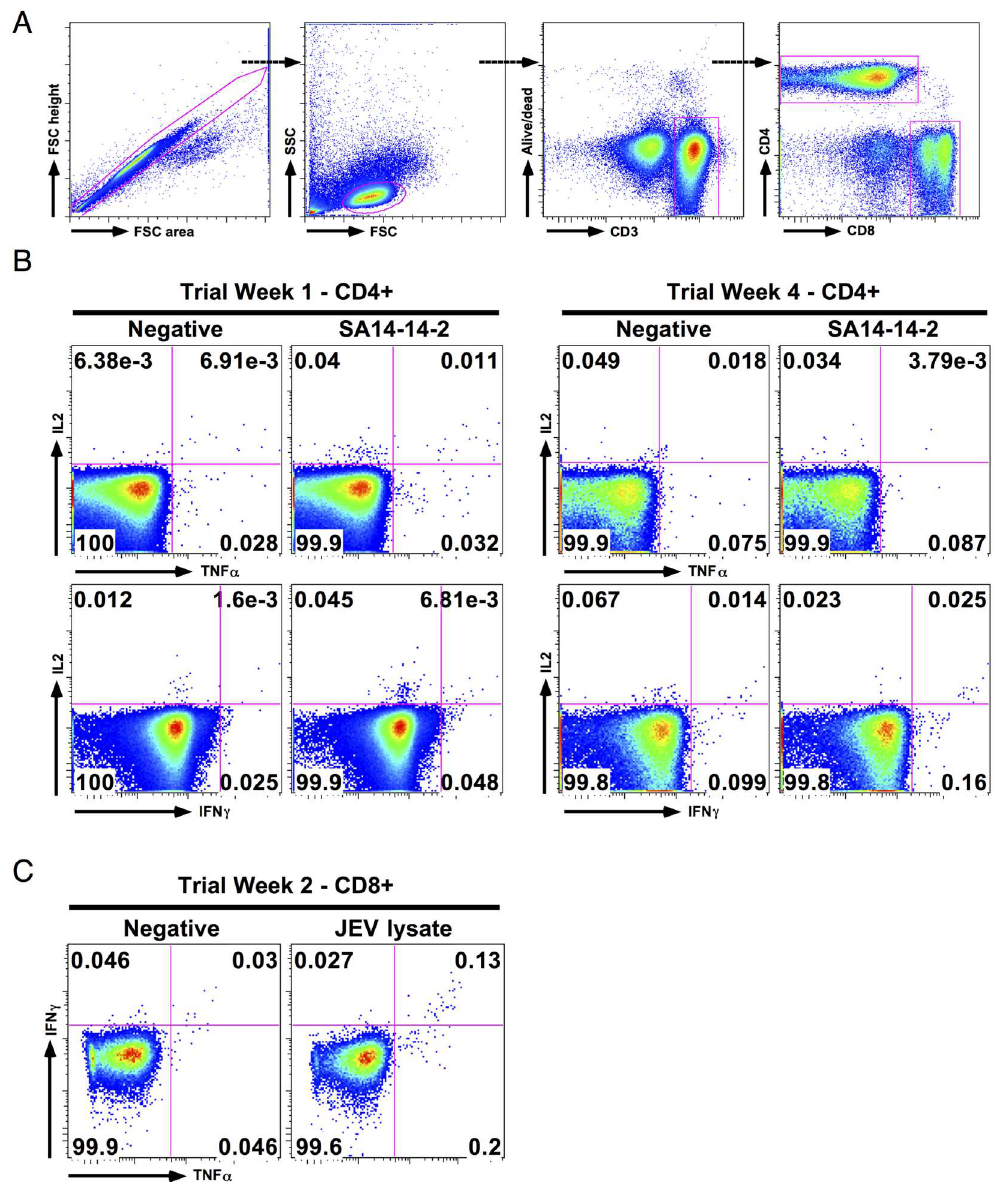
Fig 2. Example data of JE vaccine specific T cell responses by intracellular cytokine staining (ICS). Example flow cytometry data from subject VA019/3, who was JEV NAb positive at baseline, throughoutthe first four weeks of the study are shown. Data are log 10 fluorescence units. (A) Examplegating strategy; the same strategy was used for all experiments. (B) CD4 + T cell responses at trial week 1 and week 4, measuredby overnight stimulationof PBMC with approximately 10 4.4 PFU JEV SA14-14-2. A transient IL2 single positive responsewas present at week 1 that was no longer seen over the background at week 4. (C) CD8 + T cell responseto wild type JEV infected cell lysate, used at 80 ng/ml JEV E protein concentration at trial week 2, measuredby ICS after stimulationof whole bloodfor six hours. The CD8 + T cell IFN γ responsewas only detected at week 2, consistent with the peak in ELISpot response(S1 Fig).